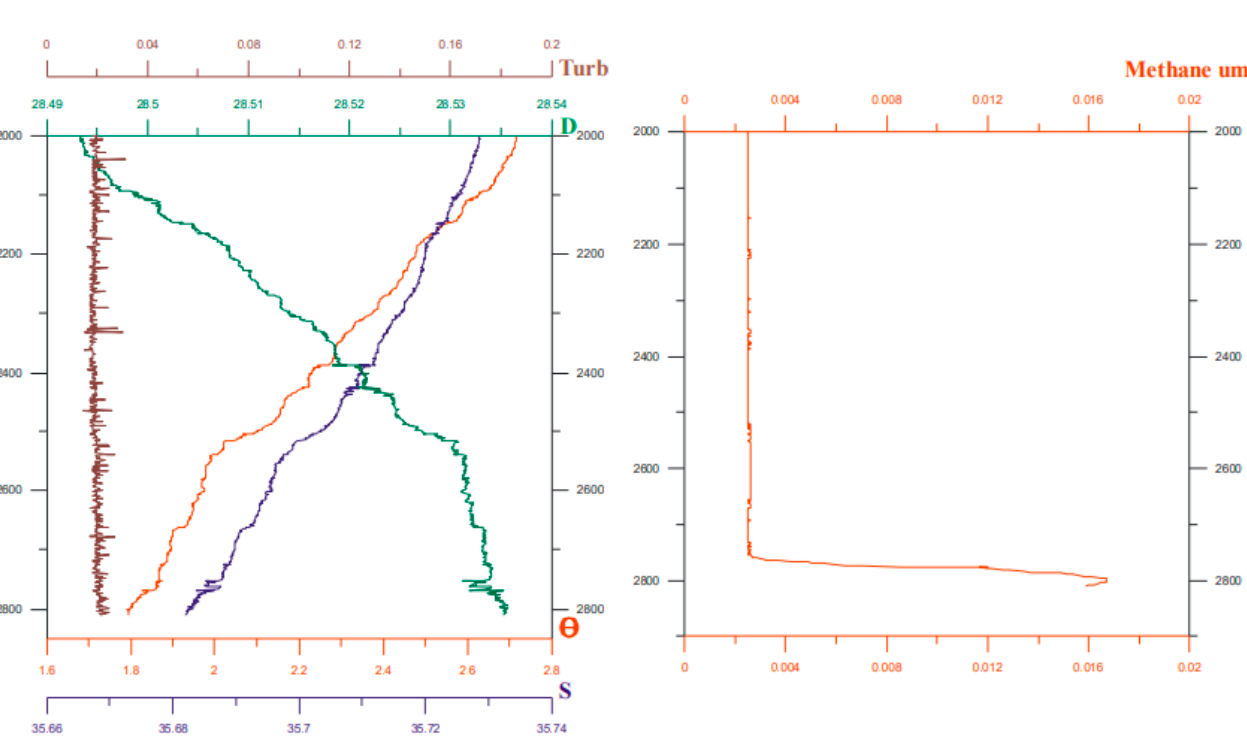
Figure 14. Results of CTD sounding at the Koralovoye field, station 41L173. Left: brown—turbidity, FTU; blue—salinity, ‰; red—temperature, °C; green—density, kg/m3; right graph: methane concentration, µmol/L.